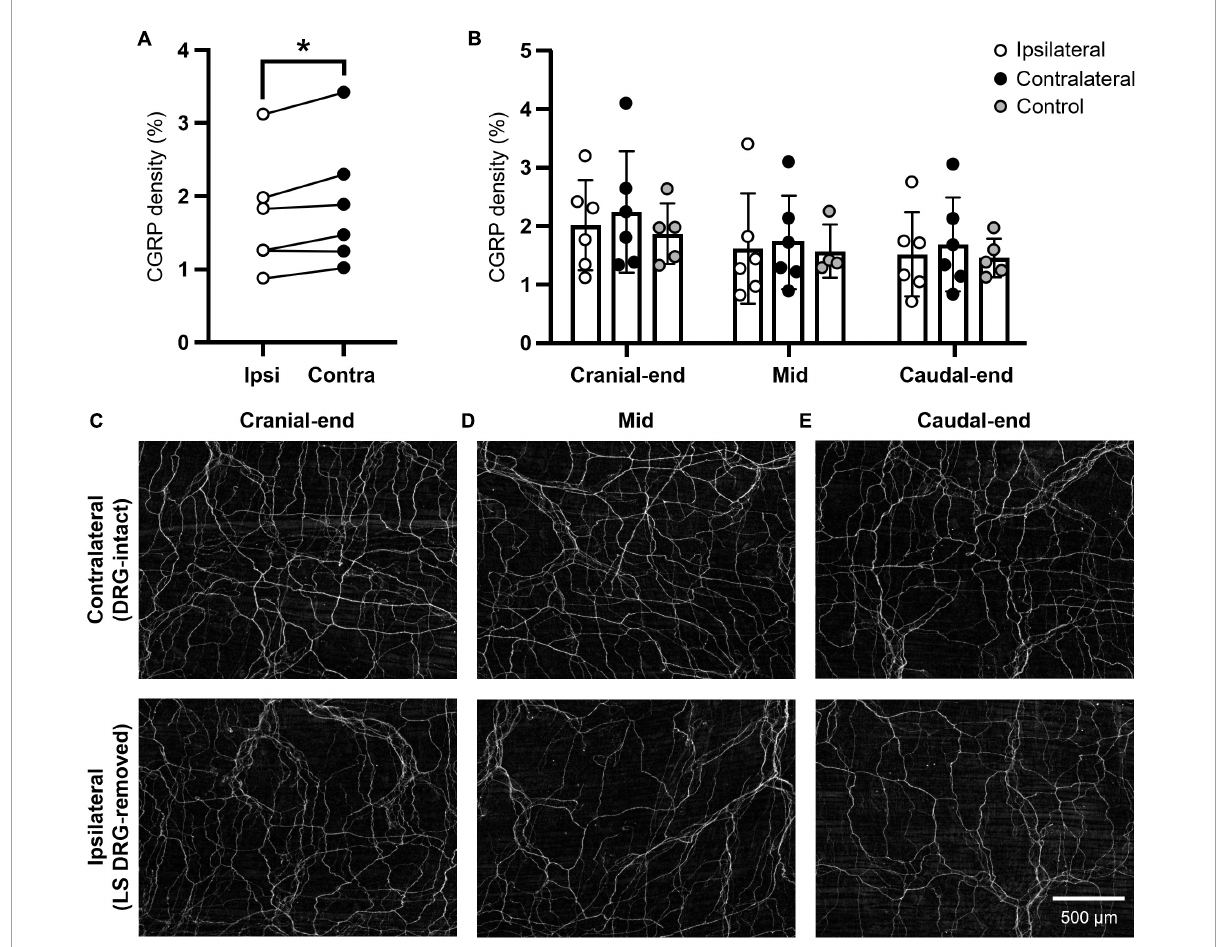
FIGURE1 Density of CGRP immunoreactivity in the mouse uterine horn following unilateral lumbosacral L5-S1 DRG removal. (A) Summary data of paired, average CGRP density values across the whole uterine horn following unilateral lumbosacral L5-S1 removal. A significant reduction in CGRP immunoreactivity was observed in the ipsilateral (DRG-removed) horn compared to the contralateral (DRG-intact) side ( P = 0.0265; two-way, repeated measures ANOVA with Šídák’s multiple comparisons; N = 6 per group). (B) Summary data of individual, average CGRP density values from each ipsilateral and contralateral uterine horn subregion (cranial-end, mid, caudal-end; N = 6 per group) and an independent, non-surgical control ( N = 5). No regional differences in CGRP immunoreactivity were observed between the ipsilateral and contralateral uterine horns or compared with control values (mixed-effects model (REML) with Tukey’s multiple comparisons). (C) Representative images of CGRP immunoreactivity from the cranial uterine horn contralateral (upper) and ipsilateral (lower) to unilateral lumbosacral L5-S1 DRG removal in the same animal. (D) Representative images from the mid uterine horn. (E) Representative images from the caudal uterine horn. Scale bar in panel [ (E) ; lower] applies to all images. Independent control data in panel (B) was originally published in Kyloh et al. (2022). LS, lumbosacral; DRG, dorsal root ganglia; Ipsi, ipsilateral; Contra, contralateral; CGRP, calcitonin gene-related